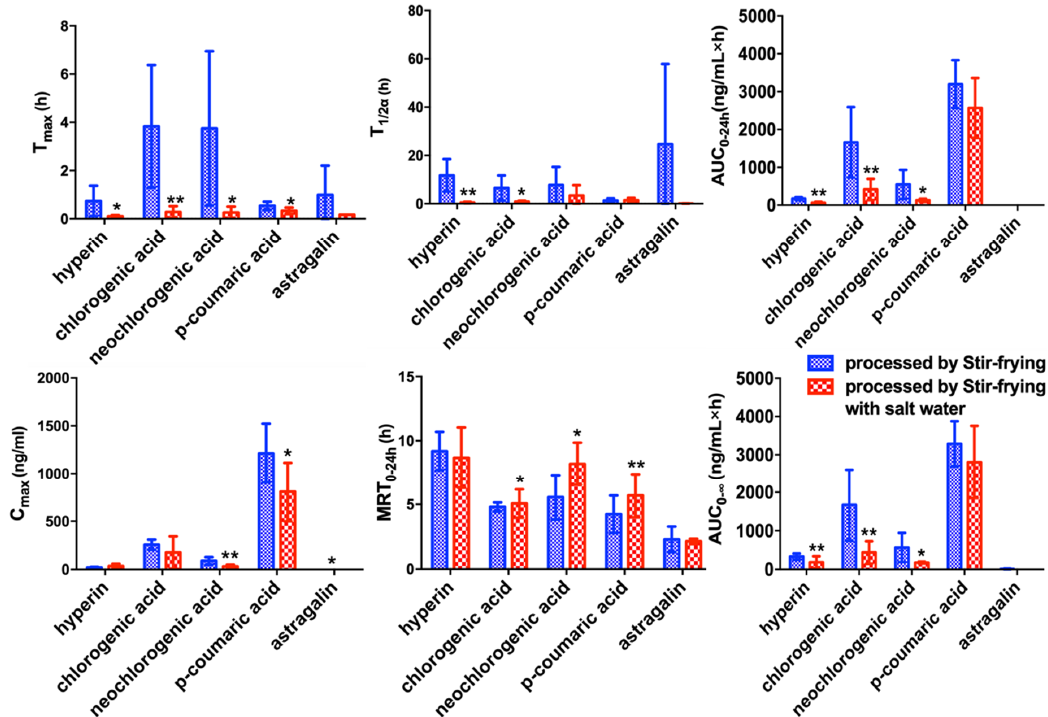
Figure 4. Pharmacokinetic comparison of oral administration of SF-CS and SP-CS extract (* p < 0.05, ** p < 0.01).